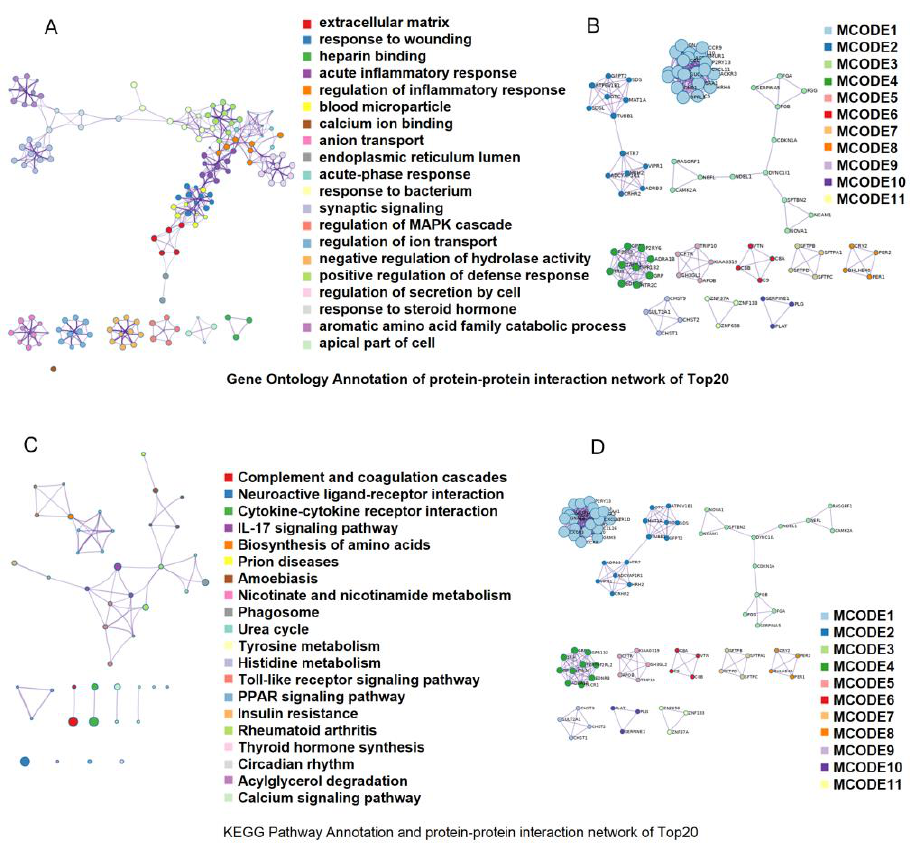
Figure 2. Function analysis of differentially expressed genes (DEGs) between the two groups based on the Gene Ontology and KEGG pathways. KEGG enrichment analysis of the differentially expressed genes [the top 20 most enriched pathway terms] ( A ); enriched KEGG pathway terms for the interaction network in MCODE components ( B ); enriched GO terms for the DEGs [the top 20 most enriched pathway terms] ( C ); and enriched GO terms for the interaction network in MCODE components ( D ).